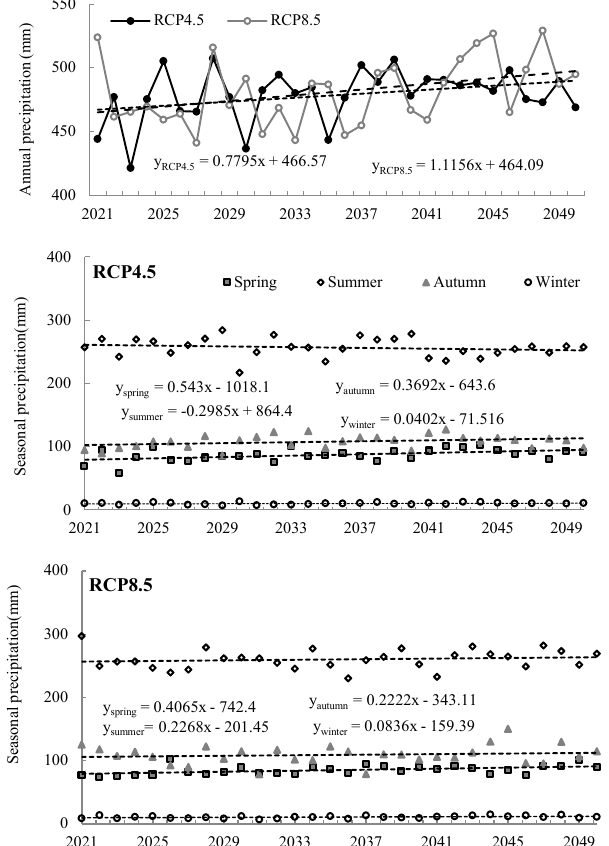
Figure 4. The time series of annual and seasonal precipitation for RCP4.5 and RCP8.5 from 2021 to 2050 in YRB.